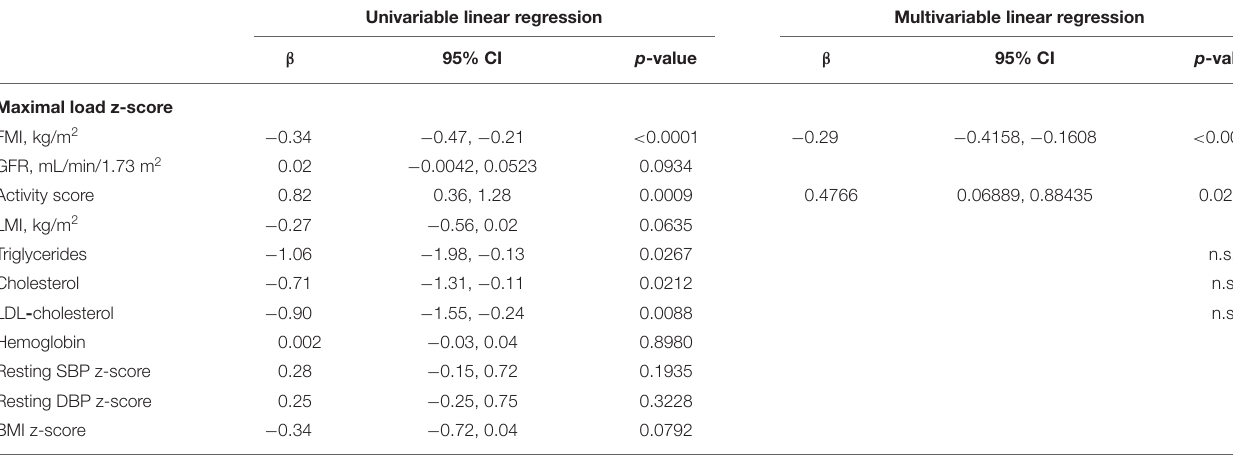
TABLE 3B | Univariable and multivariable linear regression of maximal load z-score in 38 kidney transplanted children. Univariable linear regression Multivariable linear